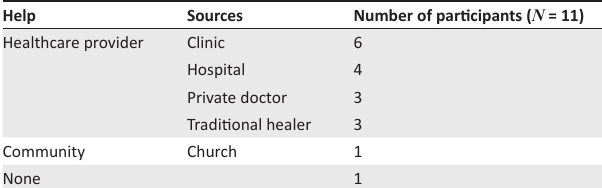
TABLE 1: The reported sources of help in